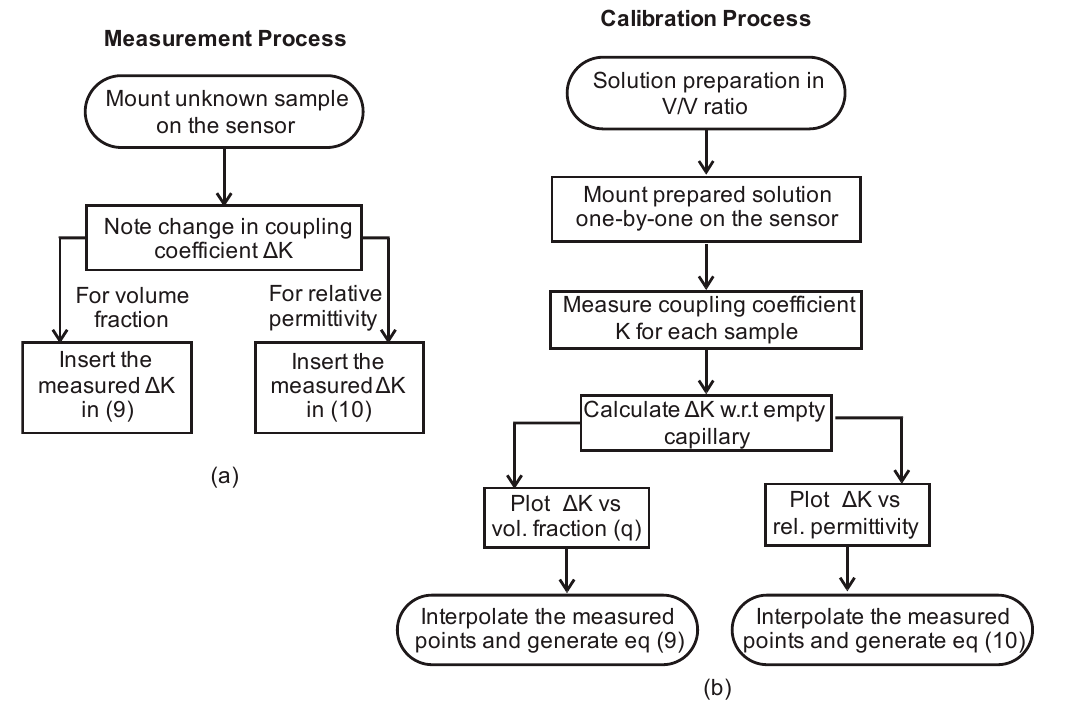
Figure 11. Functionality flow chart. ( a ) Steps for measuring unknown sample from pre-calibrated solution category. ( b ) Calibration steps to add a new solution category.